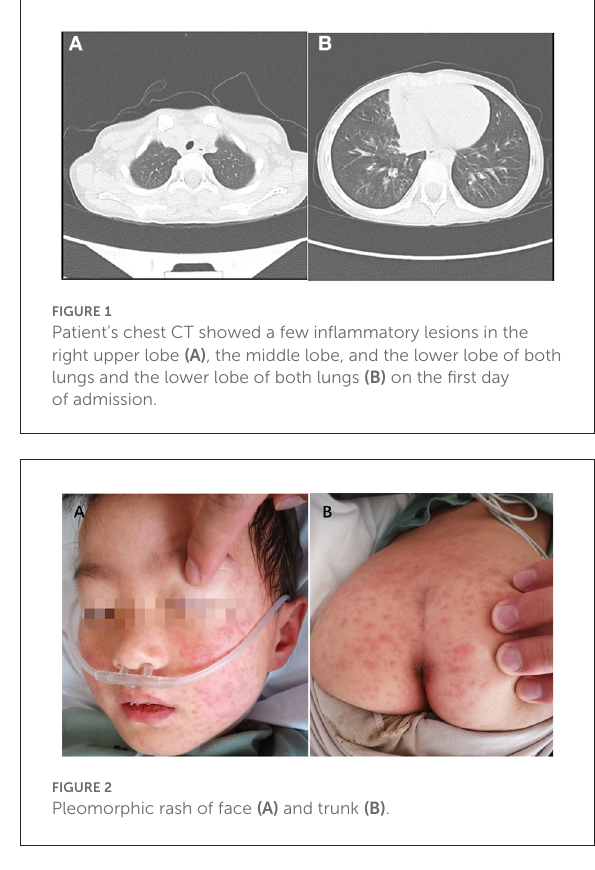
invade endothelial cells, leading to endothelial cell damage and thrombosis. Multiple organ damage may be associated with endothelial damage caused by viral infections (10, 20,